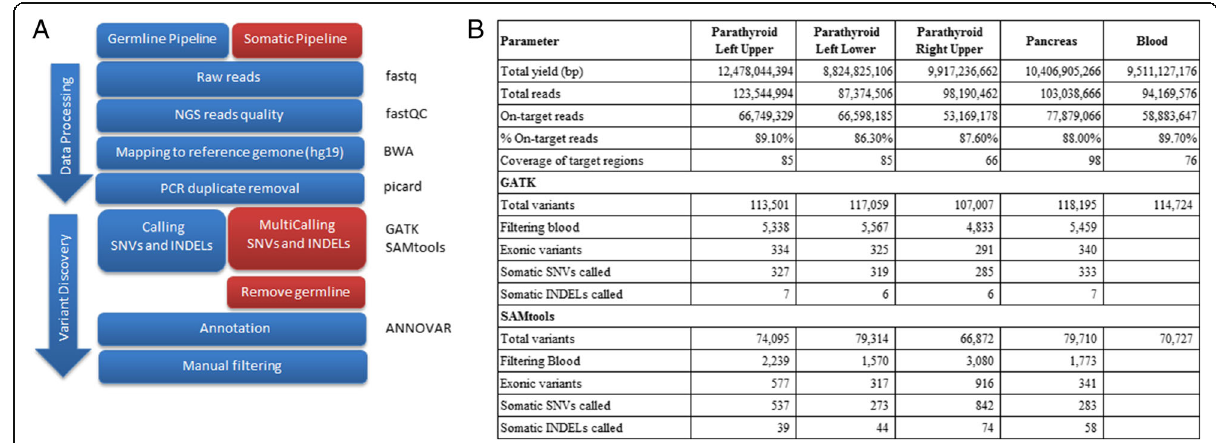
Fig. 2 Whole-exome sequencing analytical pipelines. a Two workflows are present: Germline detection and somatic detection. Red highlights the difference between our germline pipeline and the somatic pipeline. b Summary exome sequencing statistics for all four tumor tissues and